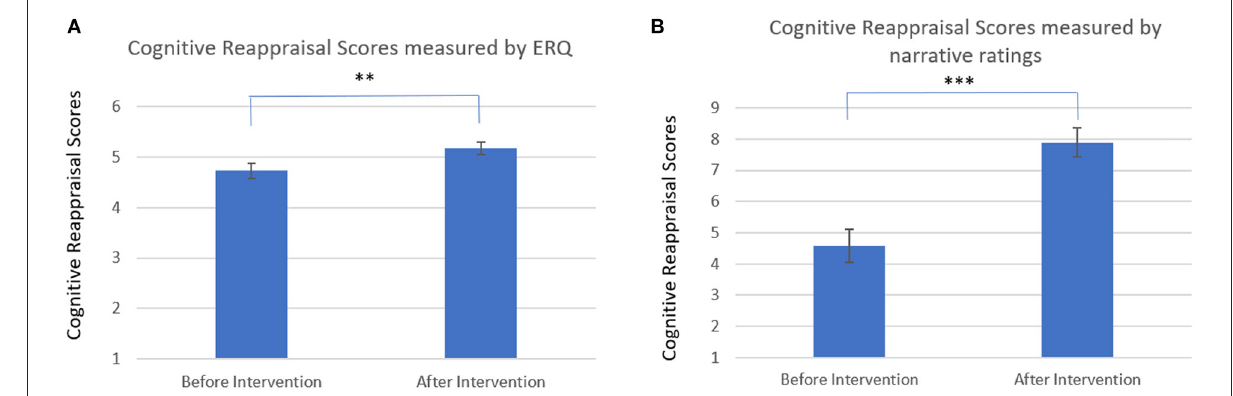
FIGURE1 (A) Cognitive reappraisal scores measured by ERQ. Results indicate an increase in cognitive reappraisal, as measured by the emotion regulation questionnaire, after intervention. (B) Cognitive reappraisal scores measured by narrative ratings. Results indicate an increase in cognitive